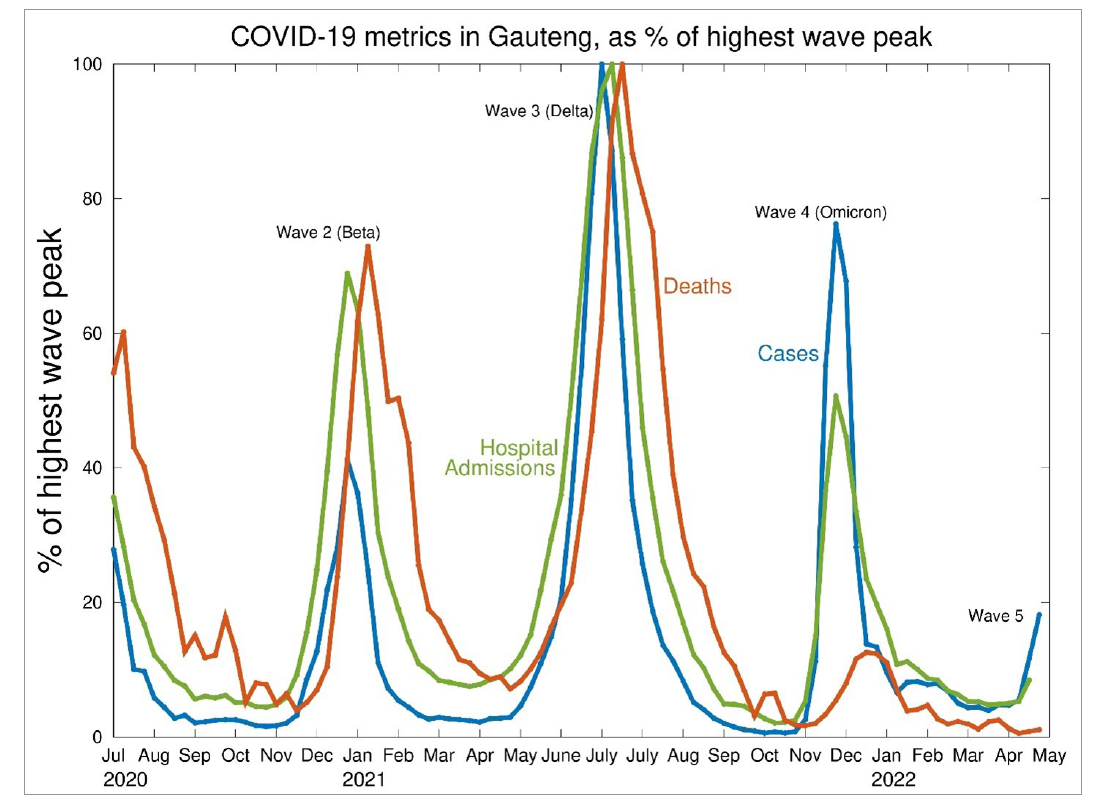
Figure 3: COVID-19 metrics of cases, hospital admissions, and deaths, in Gauteng, as a percentage of highest wave